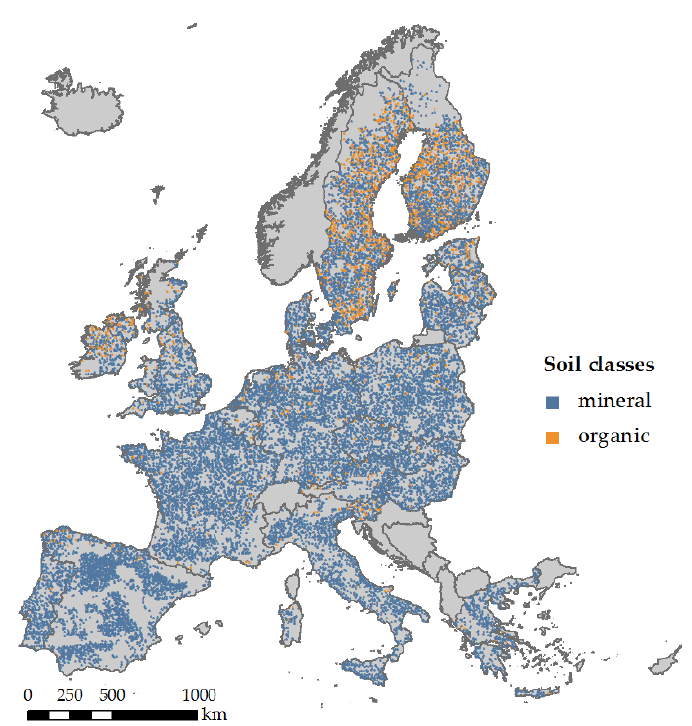
Figure 1. Distribution of mineral and organic soils from Land Use/Land Cover Area Frame Survey (LUCAS) soil spectral library.